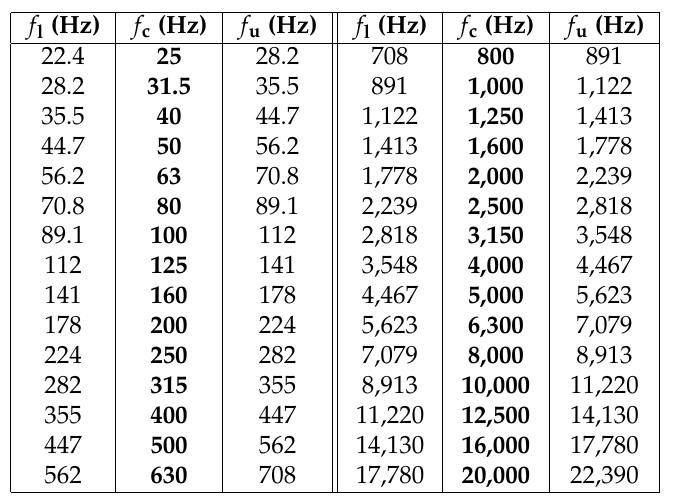
Table 2. ISO standard for one-third octave frequency bands [61]. The center frequencies are highlighted with bold